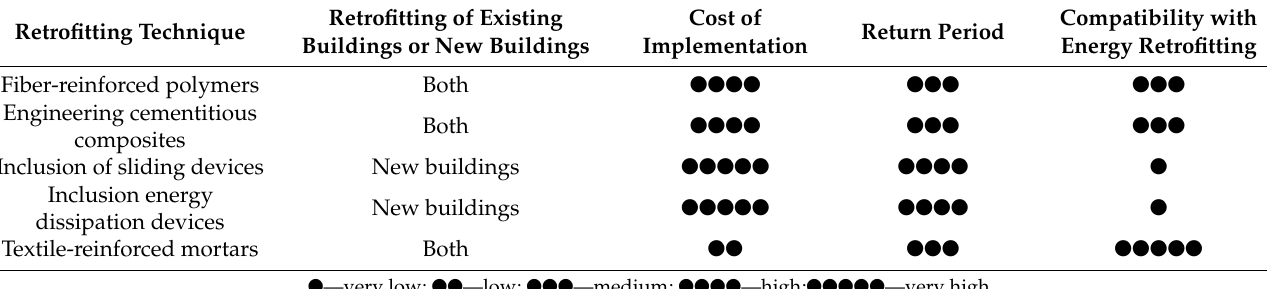
Table 1. Summary of the available structural retrofitting techniques for masonry infill